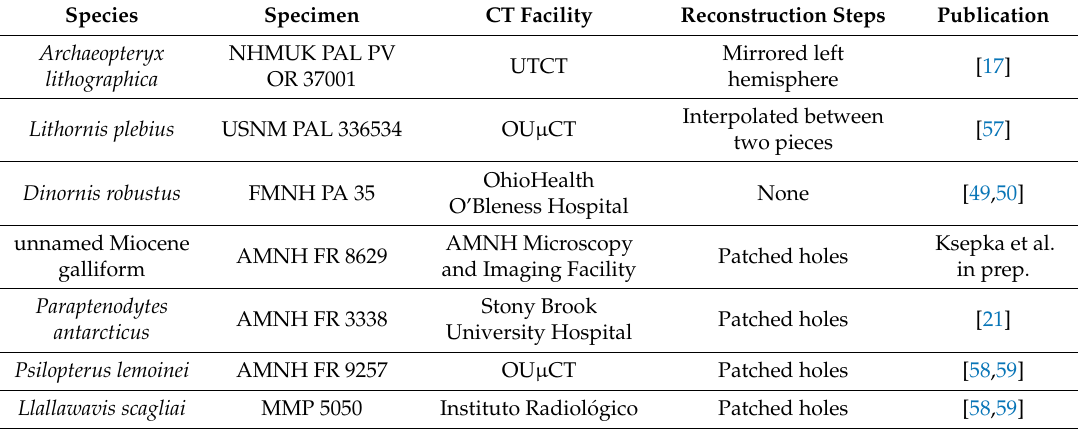
The fossil specimens used in this study, institutions at which they were scanned, reconstruction steps taken, and publications in which the scan data or endocasts were presented